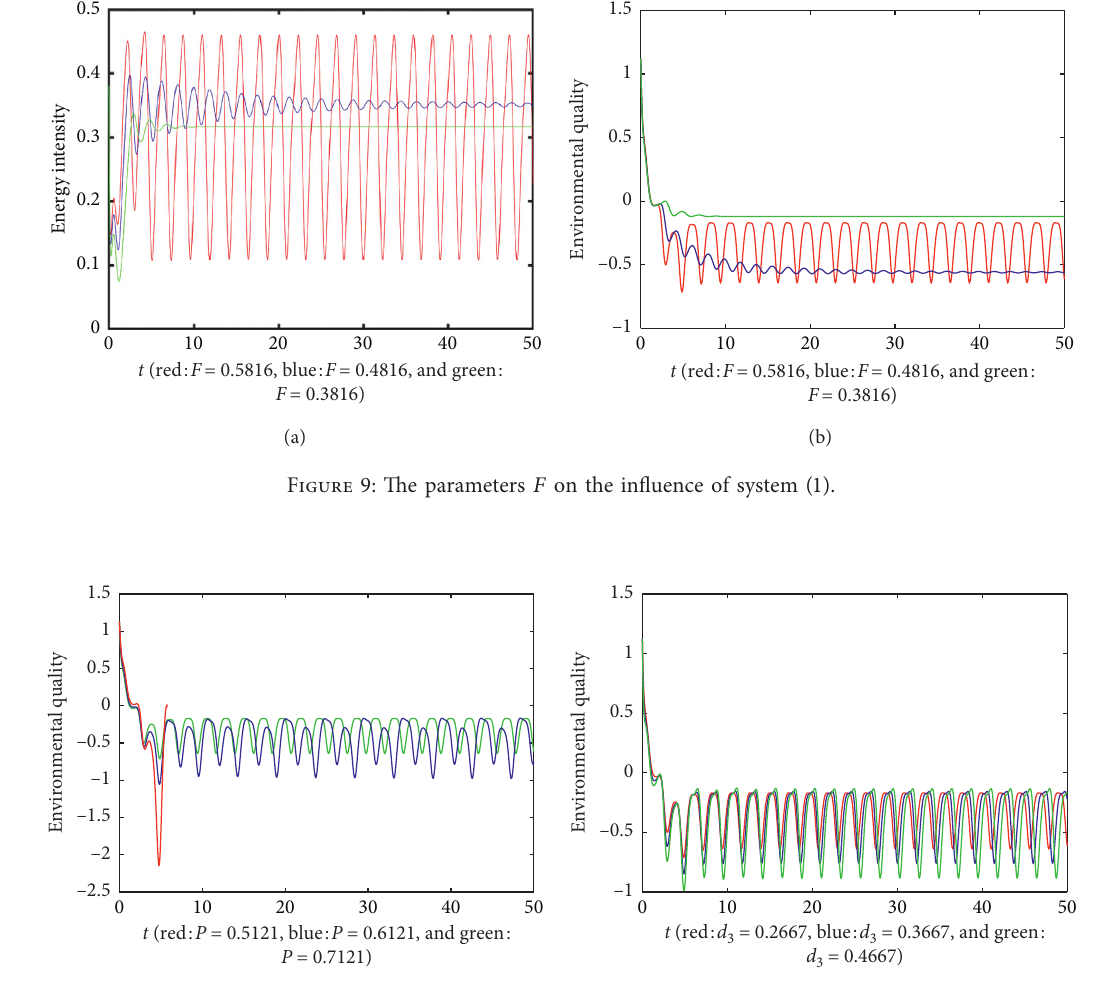
on the influence of system 3